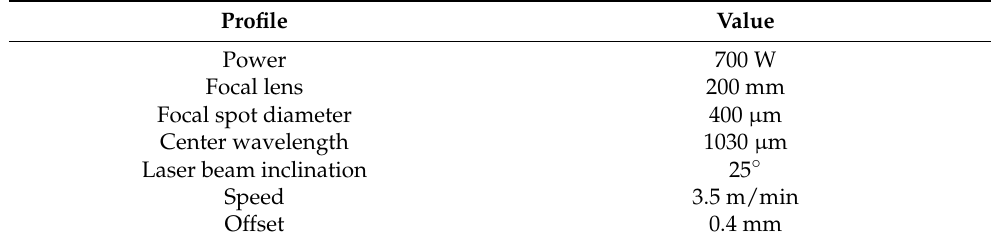
Table 1. Welded sample: manufacturing parameters.